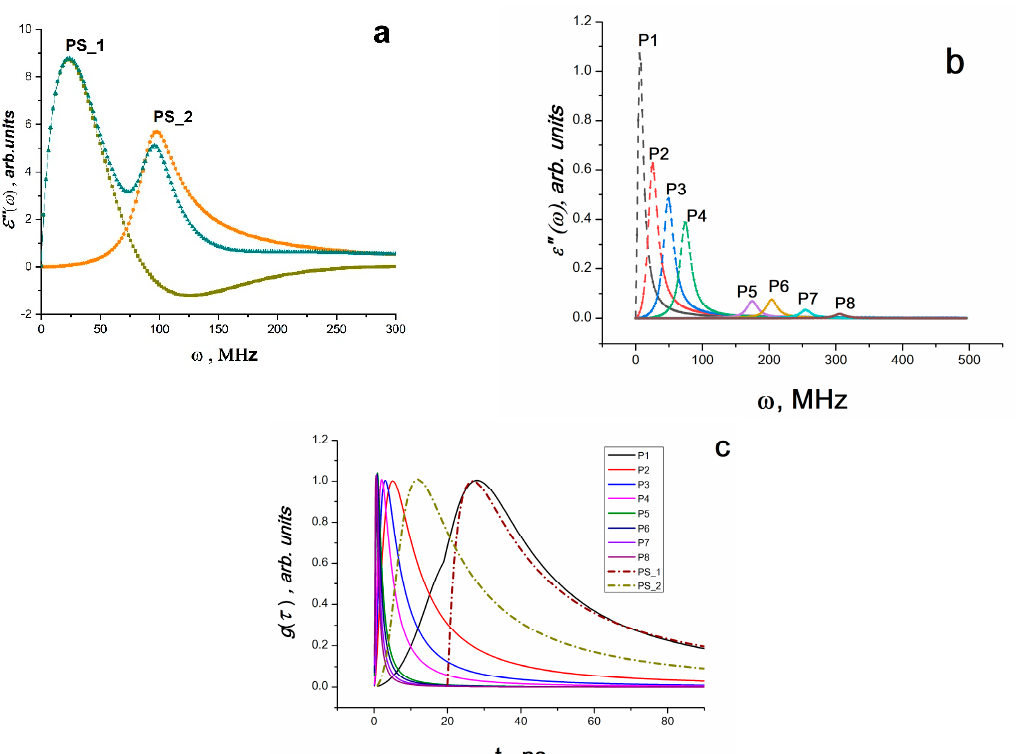
Figure 11. ( a ) Fourier image of the electrical signal for PS and the radiation bands obtained by the Havriliak–Negami method (the parameters are given in Table 4). ( b ) Fourier approximation of the image of the electrical signal for the composite K5 according to the Havriliak–Negami model (the band parameters are given in Table 4). ( c ) Relaxation time distribution curves g ( τ ) for PS matrix and composite K5. The numbers of the radiation bands and curves g ( τ ) correspond to the numbers in Table 4 (From [48] with permission). Table 4. Parameters of the Fourier bands of the spectrum for the SR bands for K5 and those of the Fourier bands of the PS spectrum (Havriliak–Negami